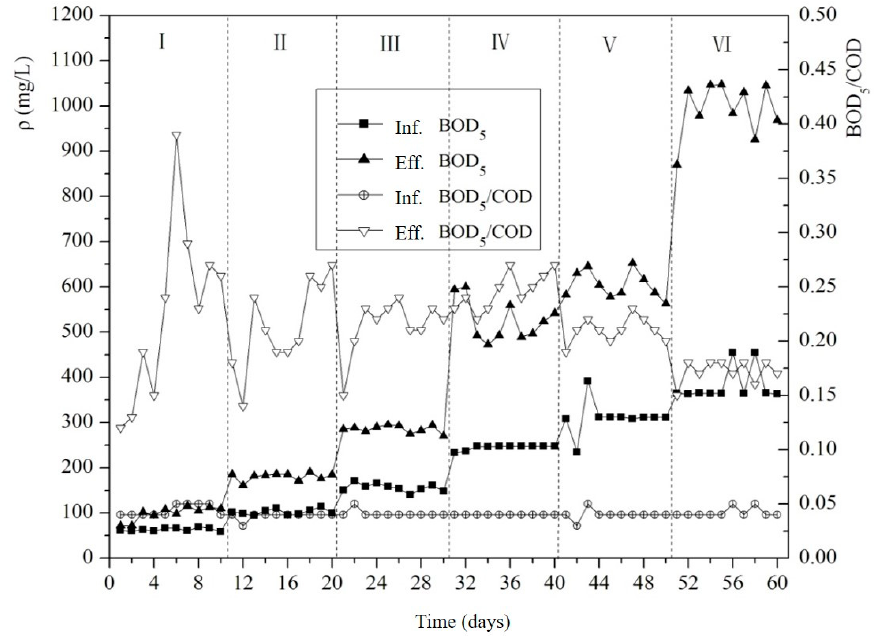
Figure 1. BOD 5 /chemical oxygen demand (COD) changes during the study (Inf., Influent; Eff., Effluent).